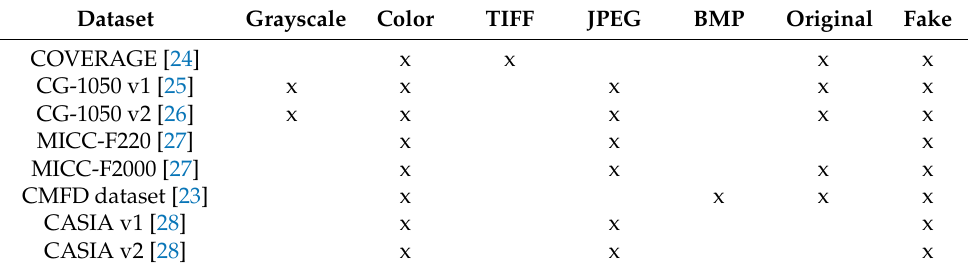
Table 3. Characteristics of the selected datasets.